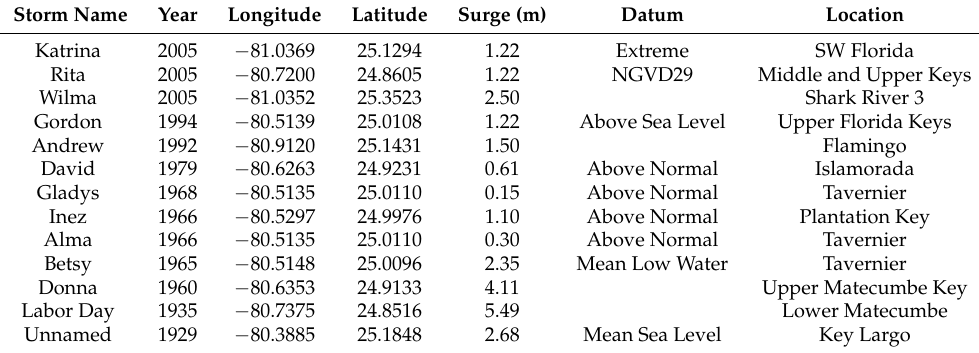
Table A3. SurgeDat database entries for a 25-mile radius centered on 25.2 ◦ N, 80.7 ◦ W in Florida